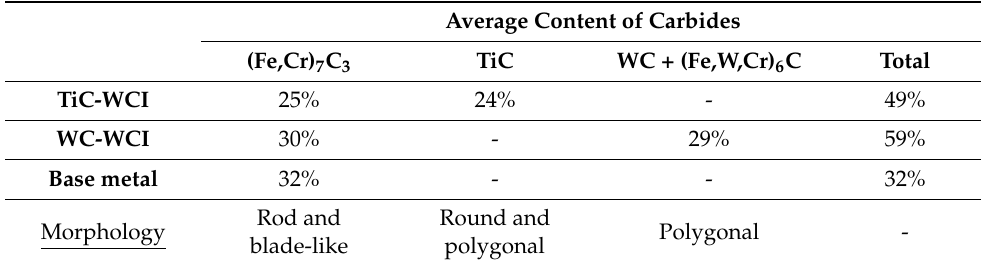
Figure 5. SEM–BSE images of the microstructure of the WC-WCI reinforced specimen. ( a ) Base metal and composite zone, ( b ) interface zone at higher magnification, ( c ) composite zone at higher magnification, and ( d ) WC particles, (Fe,W,Cr) 6 C and (Fe,Cr) 7 C 3 precipitates. Table 1. Quantification of carbides in the microstructure of the reinforced specimens.